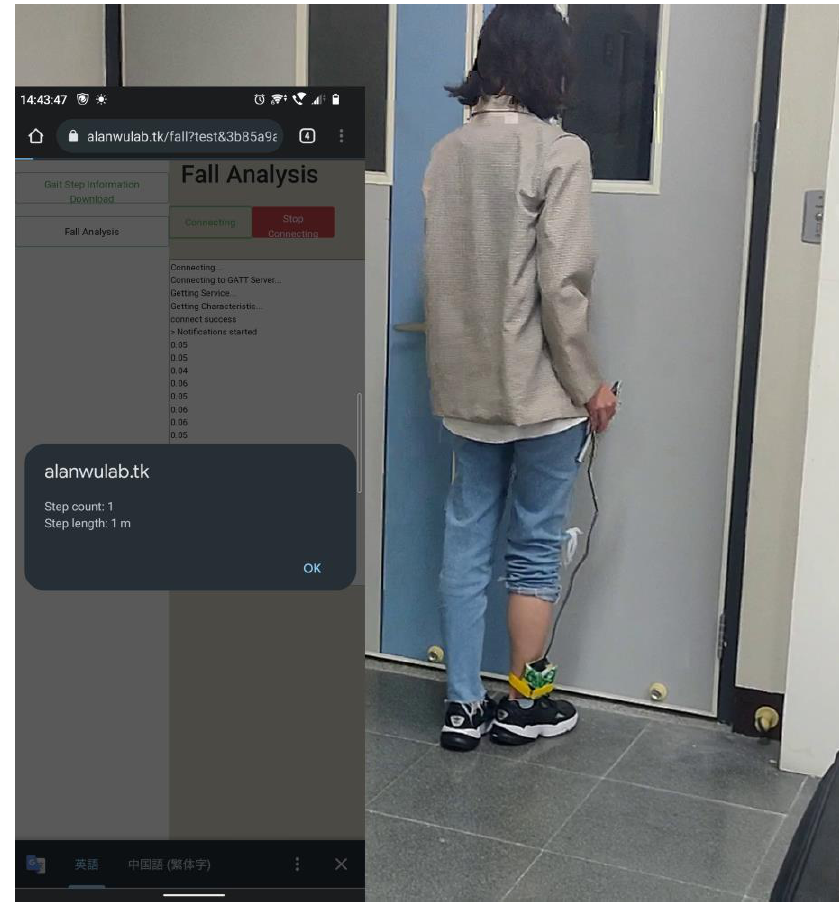
Figure 8. Step length detection of CPGAFDWD in Android.